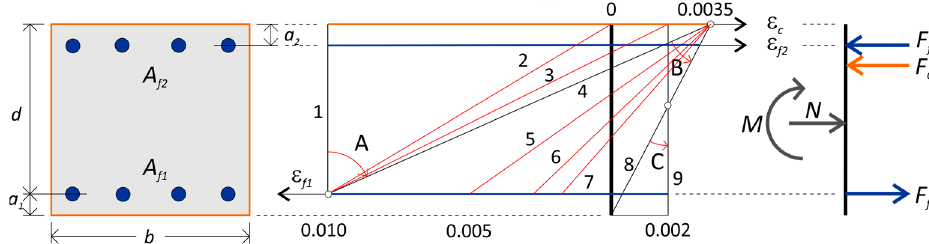
Figure 3. Cross section, strain diagrams and internal forces.